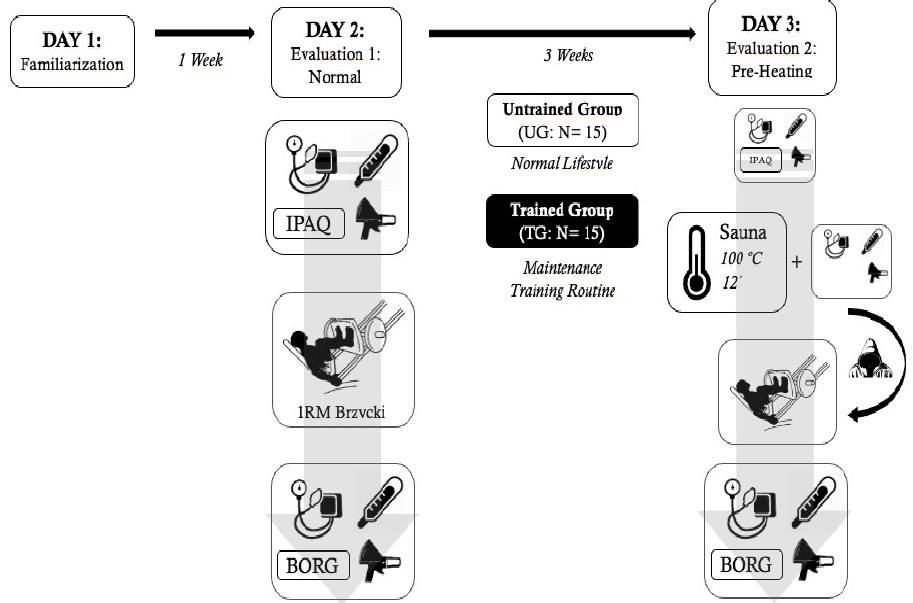
Figure 1. General study design.